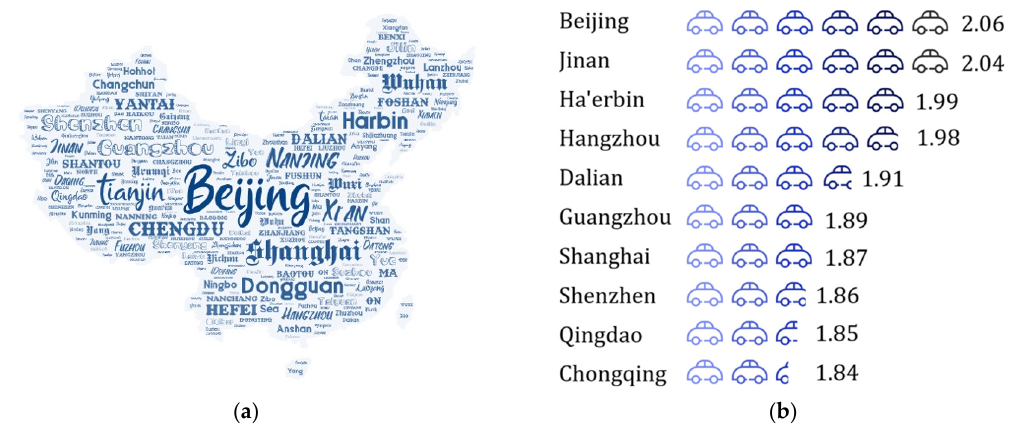
Figure 1. Basic situation of vehicle use. ( a ) China’s urban area distribution (name location does not represent actual city location, and text size represents the number of cars in each city); ( b ) Congestion delay index (2016).